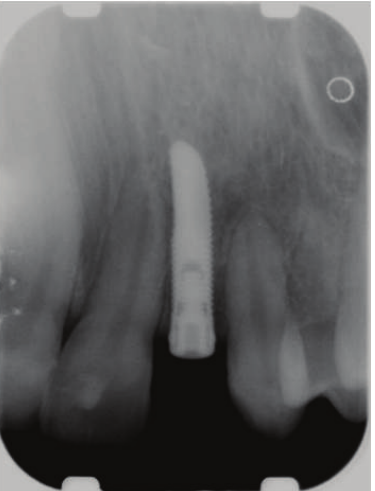
Figure 13: Radiographic control after implant placement in site to the